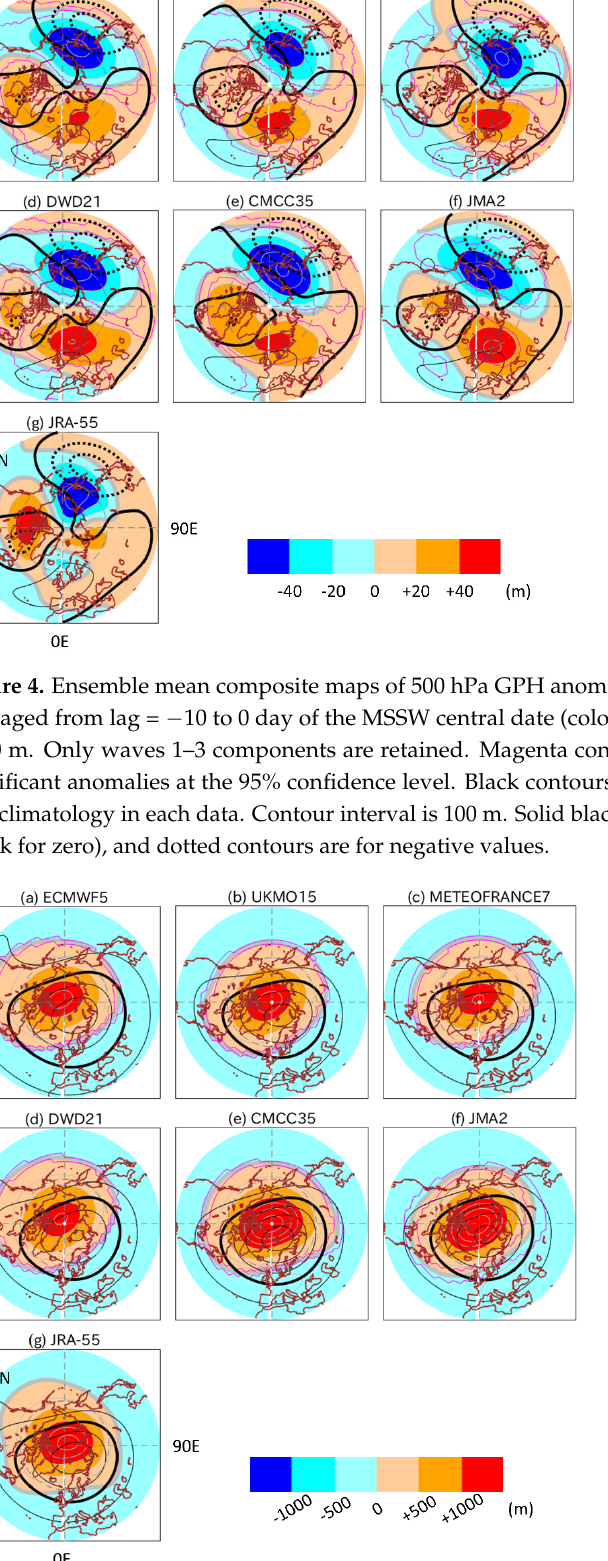
The degree of the linear relationship is quantified using the correlation coefficient in Table 2. The table reveals strongly negative correlations for the ensemble members for each system and for the ensemble means of the six systems. Figure 6. ( a ) Scatter plot between the climatological zonal mean zonal wind at 60° N, 10 hPa, and MSSW frequency, as plotted in Figure 3. Panel ( b ) uses the HFE frequency instead of the climatological zonal wind. Black diagonal line denotes the y = x line. Panel ( c ) uses the mean time change in anomalous zonal wind at 60° N, 10 hPa in response to the HFEs, i.e., from lag = −10 to 0 day.